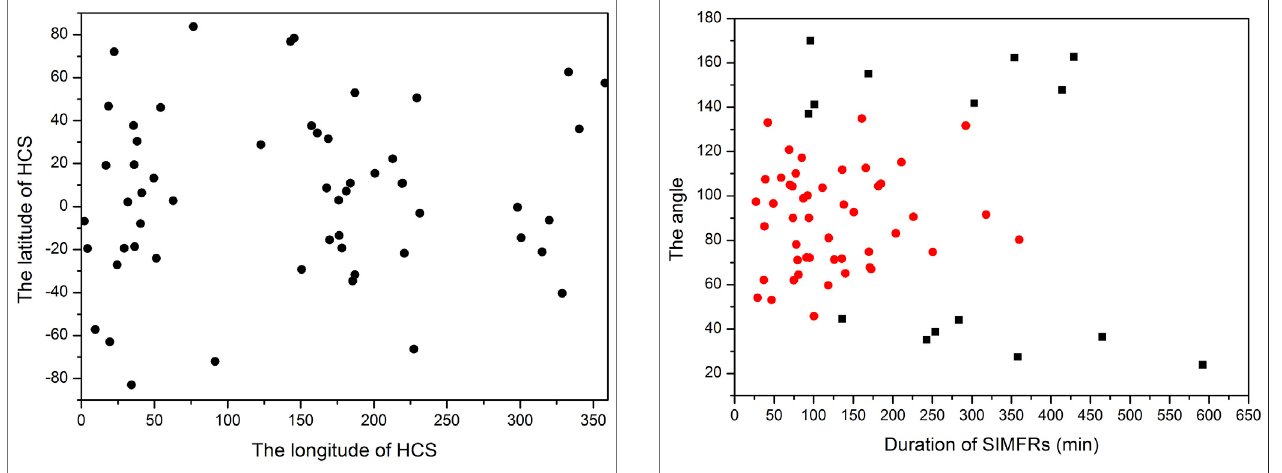
Frontiers in Physics |